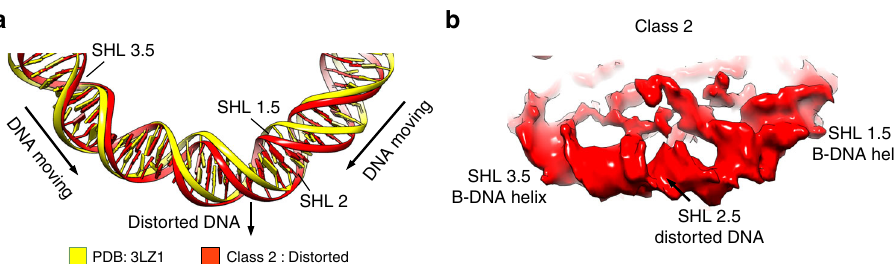
Fig. 3 Structural rearrangement of the histone core distorts the DNA at SHL 2. a Depiction of the DNA organization in the nucleosome in the X-ray structure and Class 2 cryo-EM map at SHL 2. At SHL 1.5, the DNA moves outward and toward SHL 2.5. At SHL 3.5, DNA is pulled inward and toward SHL 2.5. b Close-up view at SHL 2.5 in the Class 2 cryo-EM map. In the Class 2 map, the DNA at SHL 2.5 is less de fi ned and does not resemble a B-DNA helix, indicating distortion in the DNA structure at SHL 2.5. At SHL 1.5 and SHL 3.5, the DNA is well resolved and resembles a B-DNA